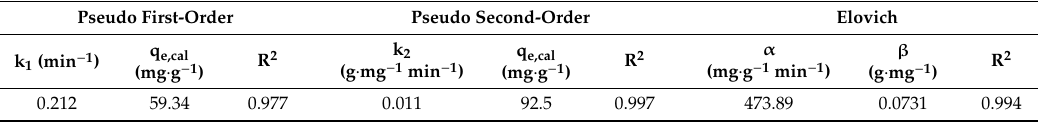
Figure 9. Kinetics study ( a ) Pseudo first-order model, ( b ) Pseudo second-order model, ( c ) Elovich model, ( d ) Intra-particle di ff usion model. Table 1. Fitted parameters of di ff erent kinetic models for DCF adsorption on